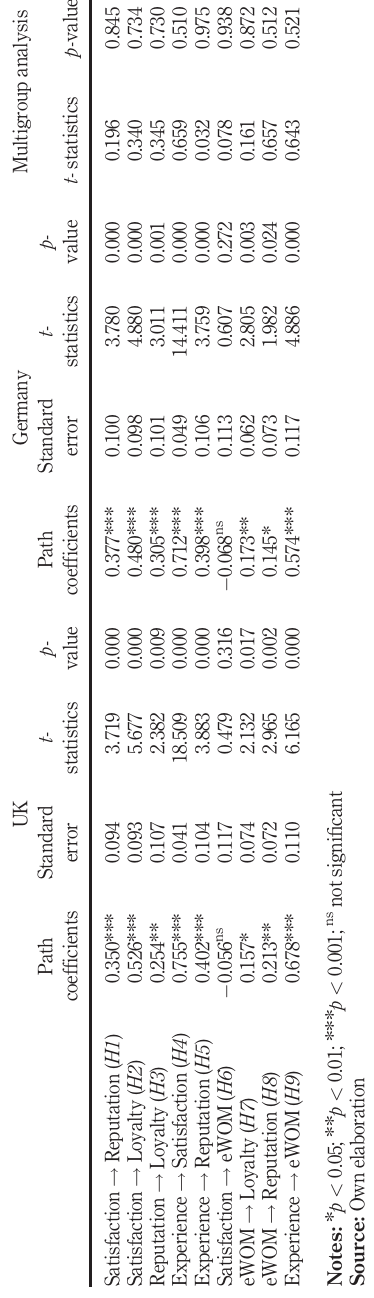
Table V. Path coefficients and multigroup